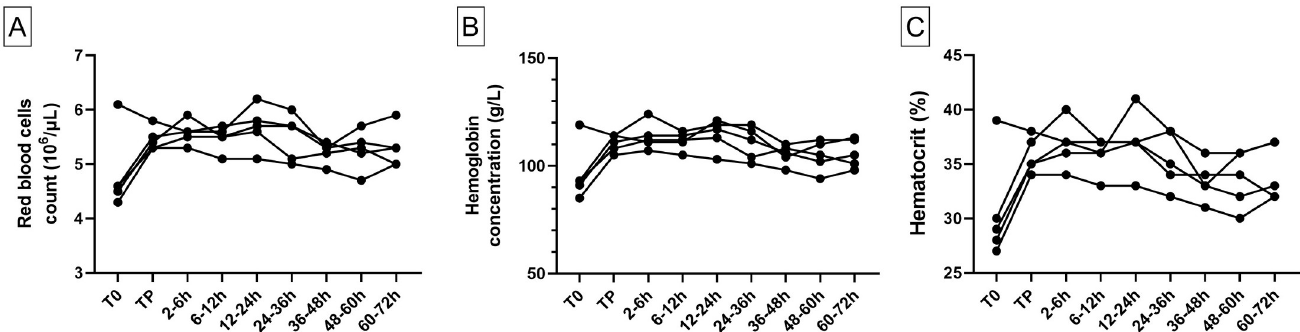
Fig 2. RBC count, hemoglobin and hematocrit animal values in the visceral model (n = 5). RBC count (A), hemoglobin (B) and hematocrit (C) are represented for each individual animal. The different times of sampling are during anesthesia before blood loss (T0) and after autologous transfusion at the end of anesthesia (TP), then during the 72 h survival follow-up period (7 sampling times following the end of the transfusion).